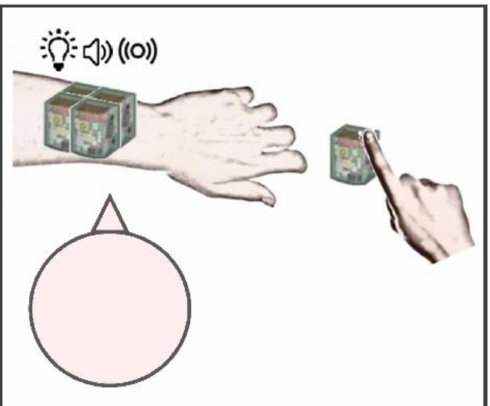
Figure 1. Experimental setup of the increasing stimulated area task. The system used for the increasing stimulated area task consisted in a technological system providing spatially and temporally coherent multisensory stimulation with real-time feedback from the user. Four units of the system were shaped in a 2 × 2 array and positioned on each participant’s left arm, with the head centrally aligned. Another unit was placed on the table, next to the right index finger, to record reaction times by tapping the upper sensitized surface. The dimensions of each unit were 2.5 × 2.5 cm 2 , for a total of 25 cm 2 with four